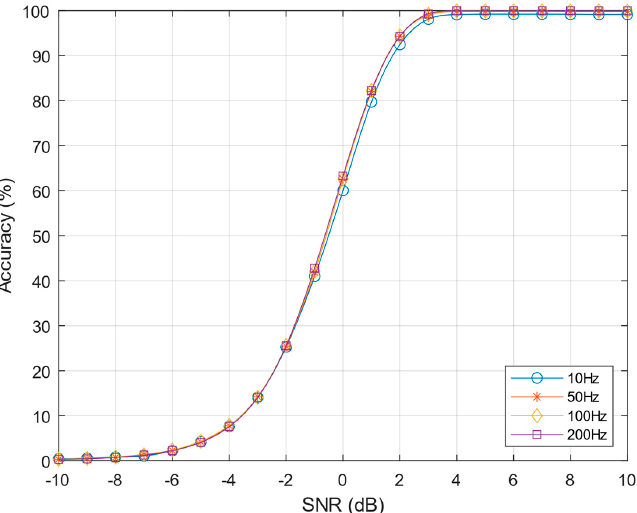
Figure 9. Performances of pre-norm algorithm varying the neuron firing rate from 10–200 Hz, k = 4 and C = 7.